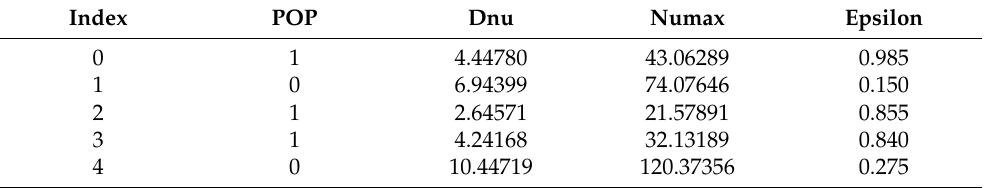
Table 3. The top 5 records analysis of asteroseismology dataset head.